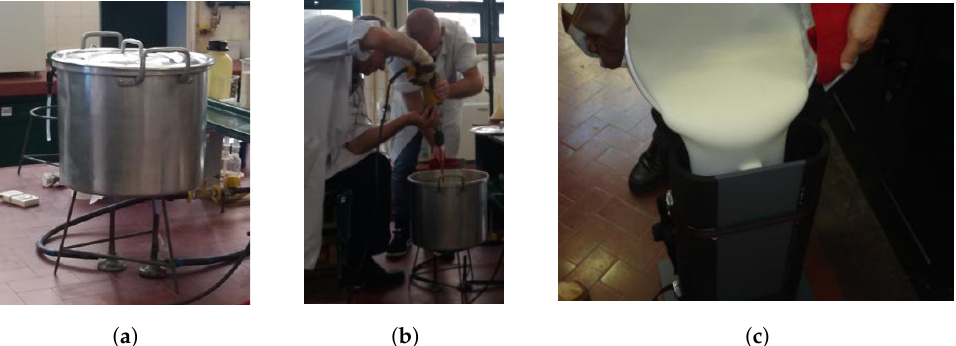
Figure 1. Photographs of the several steps of the phantom’s fabrication. ( a ) Water heating. ( b ) Ingredient mixing. ( c ) Container